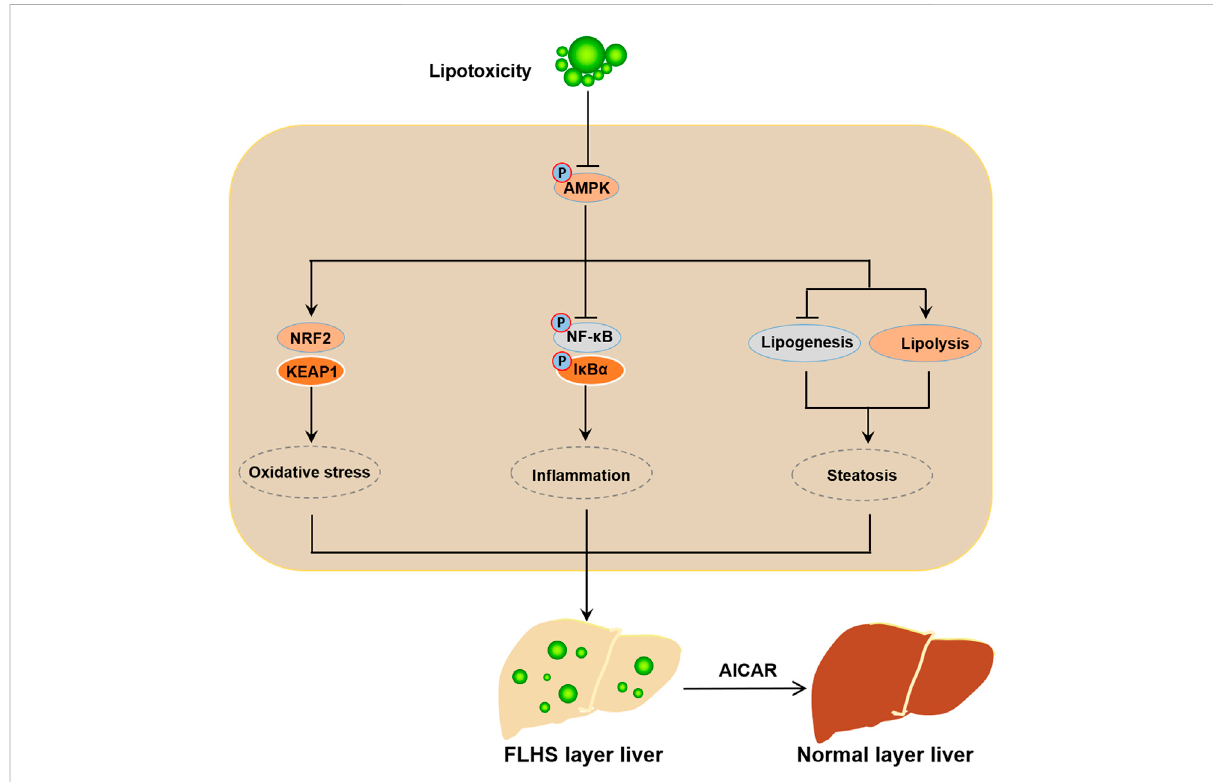
FIGURE 9 Schematic illustration of the mechanism of activated AMPK prevents the occurrence and development of FLHS. The mitigative effect of activated AMPK signal on the lipid metabolism disorder, oxidative stress and in fl ammatory response trigerred by PO-stimualtion is mainly achieved throughtheactivation ofNRF-2signaling pathway andtheinhibition ofNF- κ Bsignaling pathway inprimarychicken hepatocytes;whichimpliedthat AMPK may be a potential target factor for the prevention of FLHS occurrence in laying